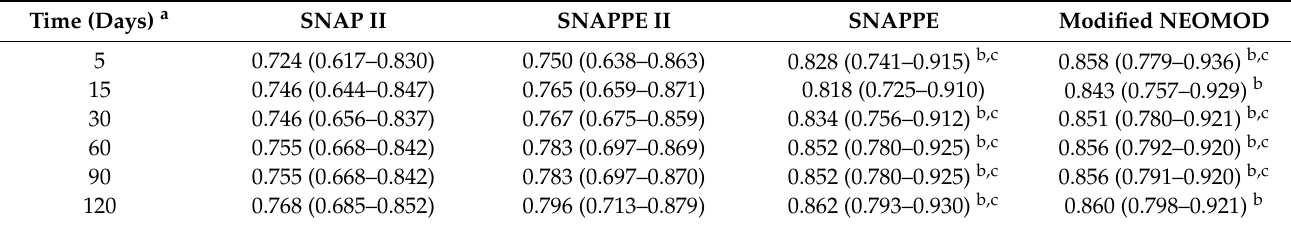
Table 2. Area under curve (AUC) showing the prognostic power of the mortality indexes over time.